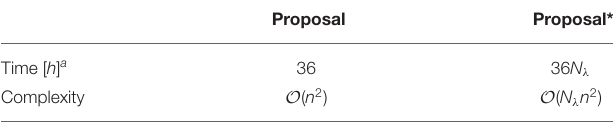
TABLE 4 | Algorithm complexity of developed learning procedures.